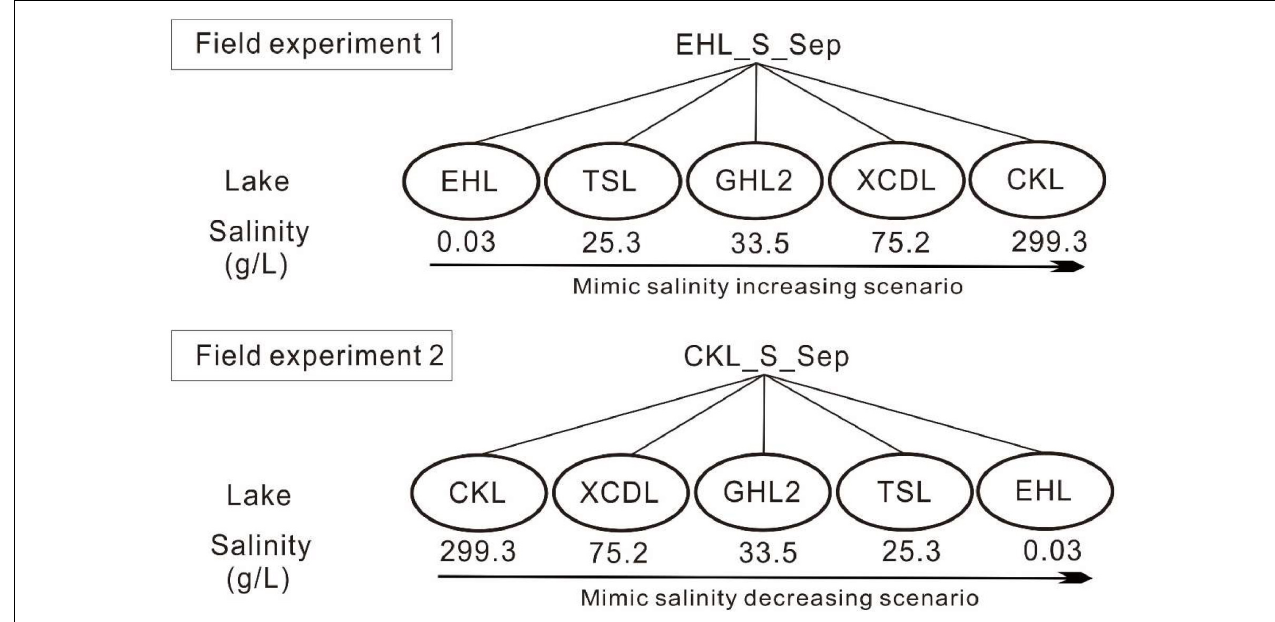
FIGURE 1 | Experimental design. Experiment 1 was to simulate increasing salinity scenario (salinization); the freshwater sediments (EHL_S_Sep) were transplanted into EHL, TSL, GHL2, XCDL, and CKL, respectively. Experiment 2 was to simulate decreasing salinity scenario (desalinization): the salt lake sediments (CKL_S_Sep) were transplanted into CKL, XCDL, GHL2, TSL, and EHL, respectively.